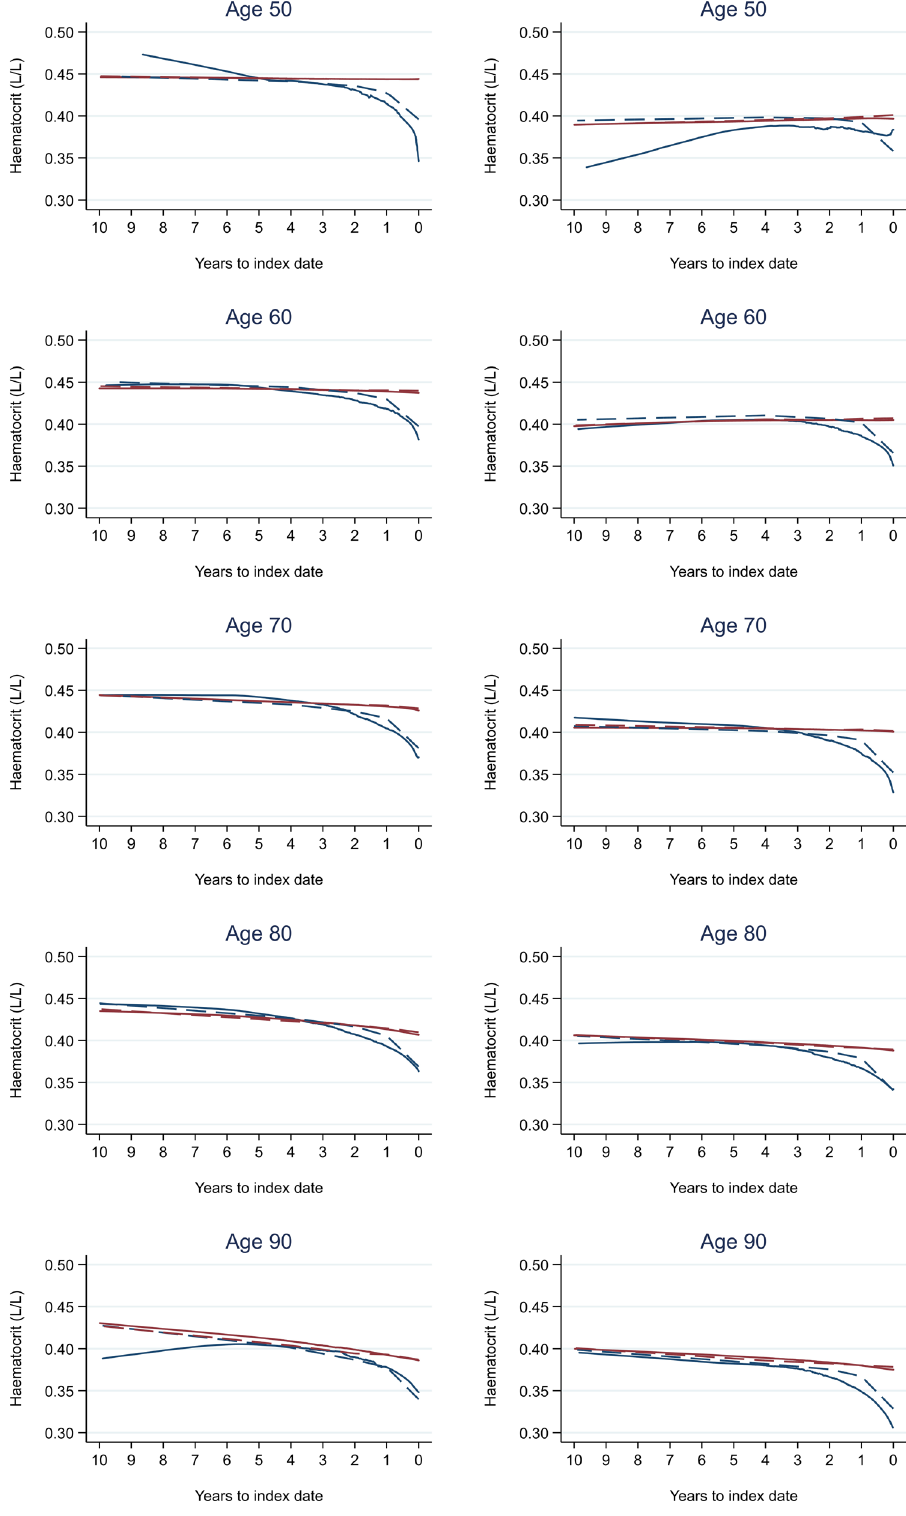
Figure 6. Haematocrit trends between cases and controls, by age at index date 1,2 . 1 Index date was the date of diagnosis for cases and a randomly selected date in the patient’s study period for controls. 2 LOWESS trends are age (+/- 3 years) and modelled (fixed effects) trends are taken at that specific age. Legend: males (left) and females (right). Colorectal cancer (blue line) and no cancer (red line). LOWESS trend (solid line) and modelled trend (dashed line).